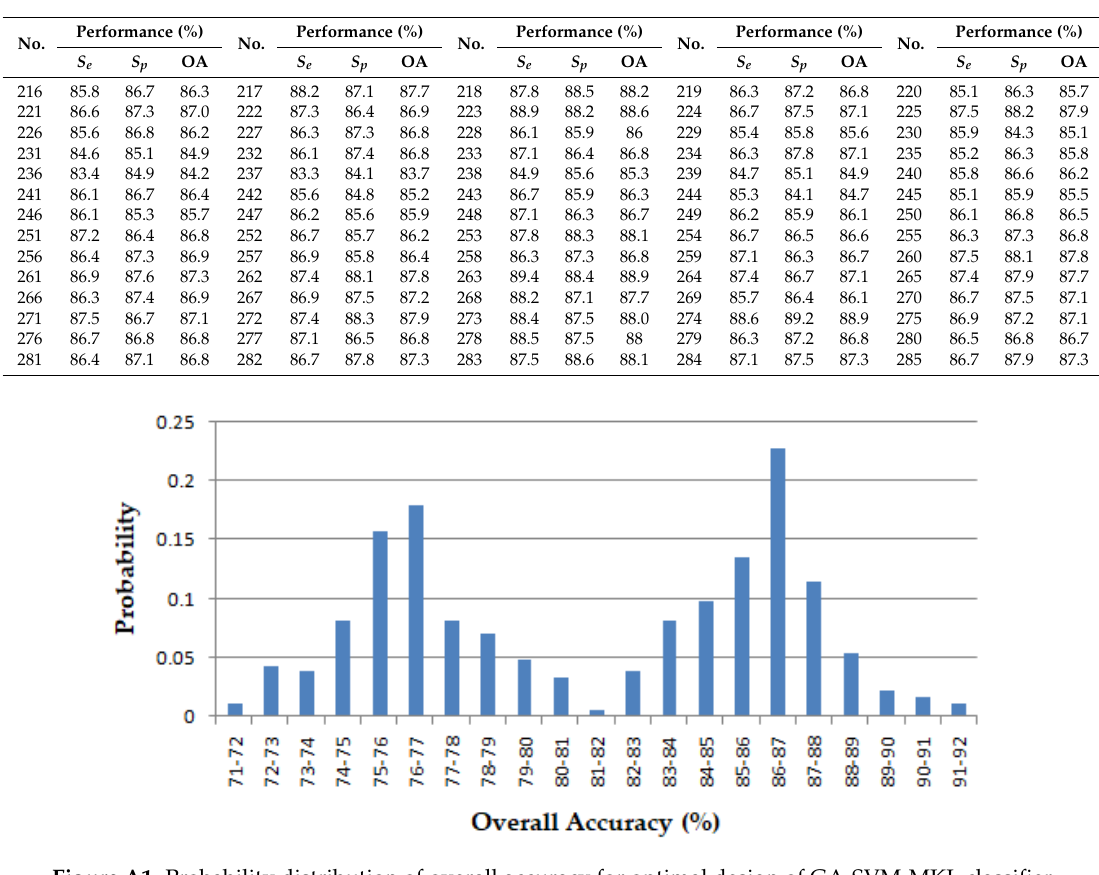
Figure A1. Probability distribution of overall accuracy for optimal design of GA-SVM-MKL classifier in 285 scenario using various kernel and kernel properties.